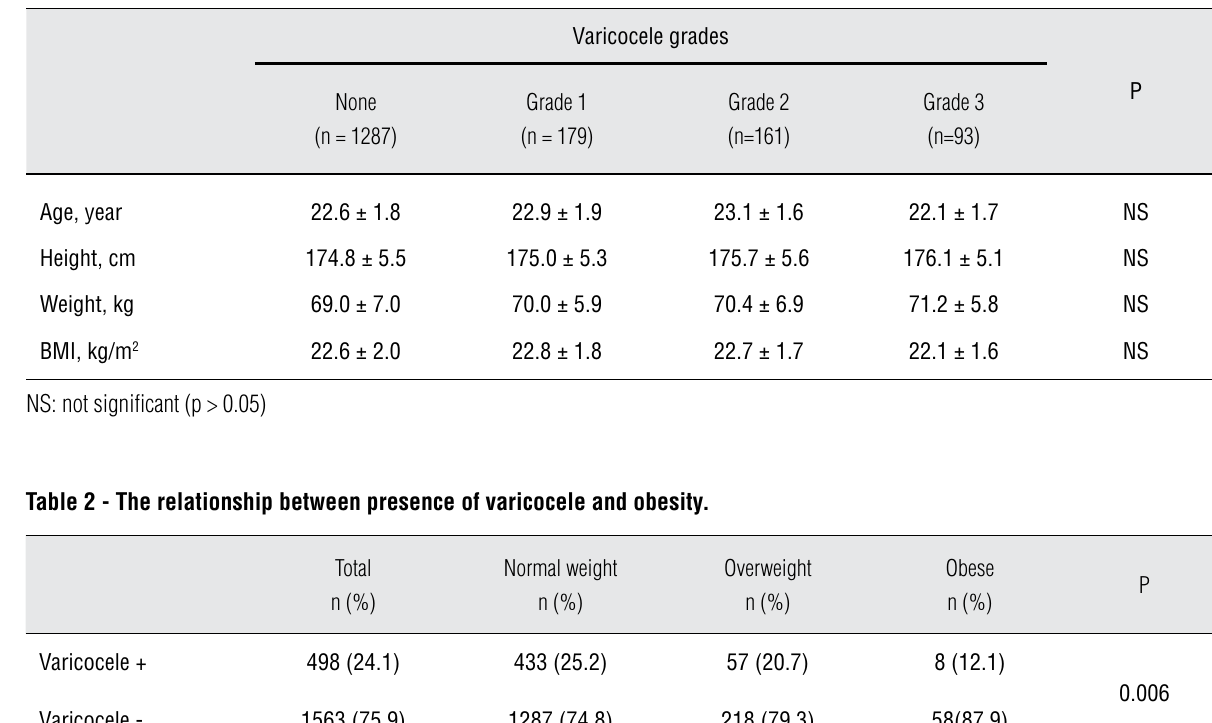
Table 1 - Anthropometric measurements of participants according to varicocele grades (mean ± sD).